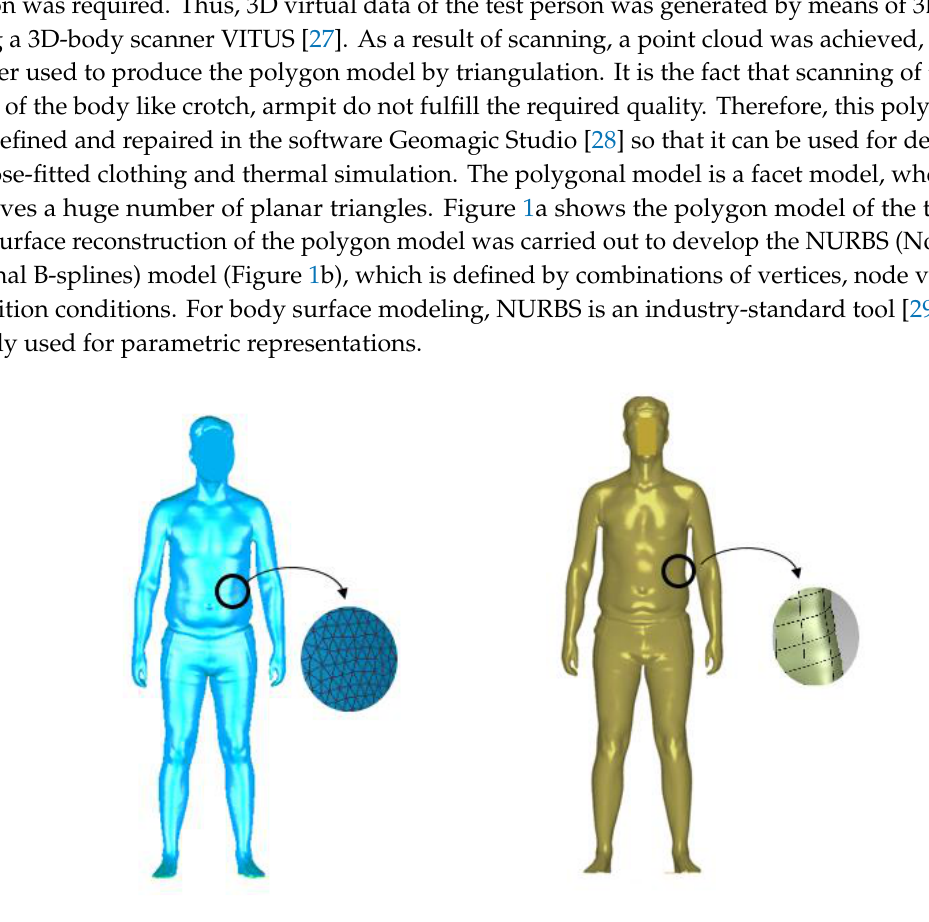
Table 1. Characteristics of